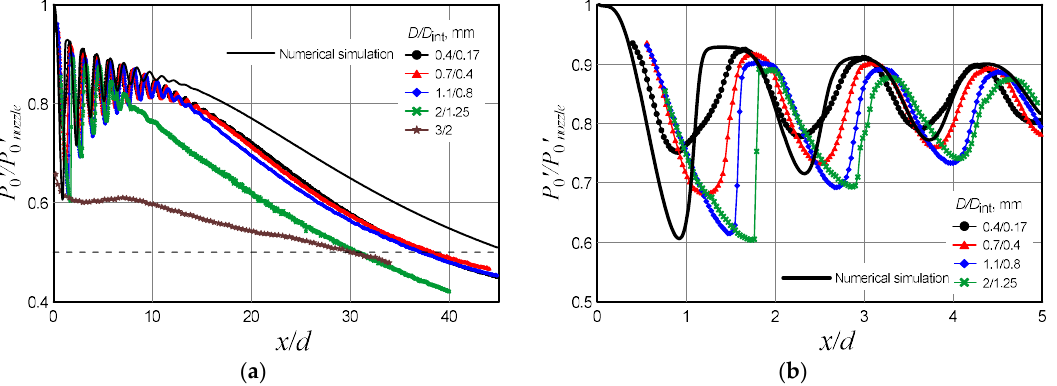
Figure 7. Pressure distribution in the jet escaping from the nozzle 1.06 mm in diameter (modeling exhaustion from the nozzle 16.1 µm in diameter). The plots in ( b ) are fragments from ( а ). It is seen that the calculations predict a greater supersonic core length than that obtained in the